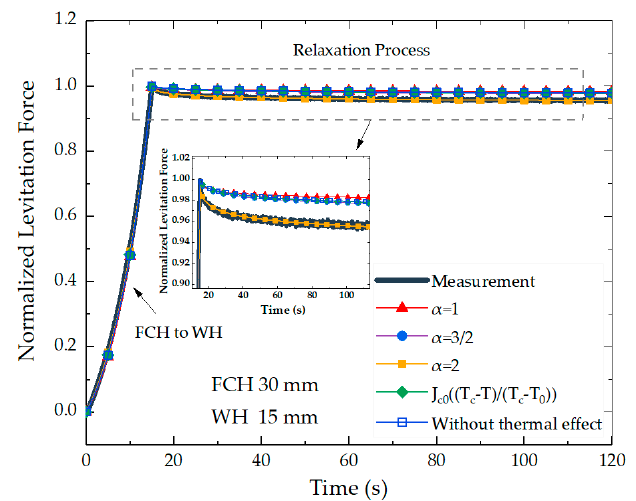
Figure 2. Normalized quasi-static levitation force versus time under different J c –T relationships of: J c = J c1 (1-(T/T c ) 2 ) α , α = 1, 3/2, 2; J c = J c0 ((T c -T)/(T c -T 0 )); J c = J c0 . The PMG in the simulation (or bulks in the experiment) moved from the FCH (30 mm) to the WH (15 mm) at the vertical 1 mm / s speed, and then relaxed for over 100 s. The original values of the levitation force at 15 s were 126.40 N (measured), 224.40 N ( α = 1), 216.58 N ( α = 3 / 2), 203.62 N ( α = 2), 216.52 N ( J c0 (( T c - T ) / ( T c - T 0 )), and 216.51 N ( J c = J c0 ), respectively.